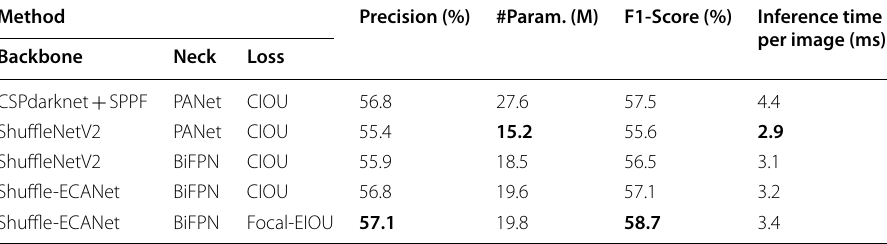
Shuffle-ECANet BiFPN The best results are marked in bold